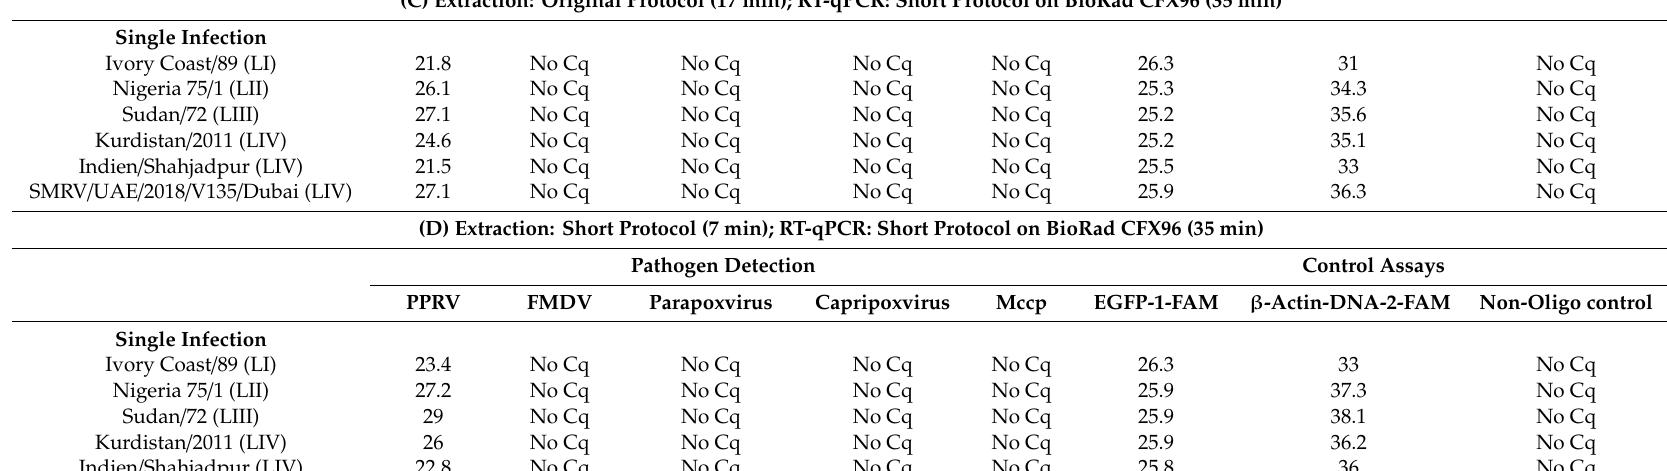
(C) Extraction: Original Protocol (17 min); RT-qPCR: Short Protocol on BioRad CFX96 (35 min)